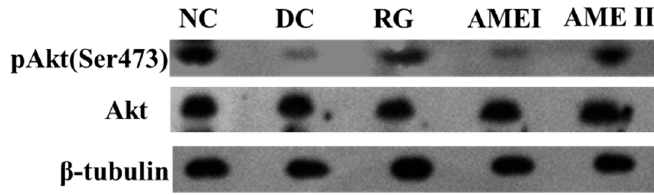
ff ect of AME on pAkt, Akt, proteins ( n = Figure 3. The effect of AME on pAkt, Akt, proteins ( n = 10). Figure 3. The e